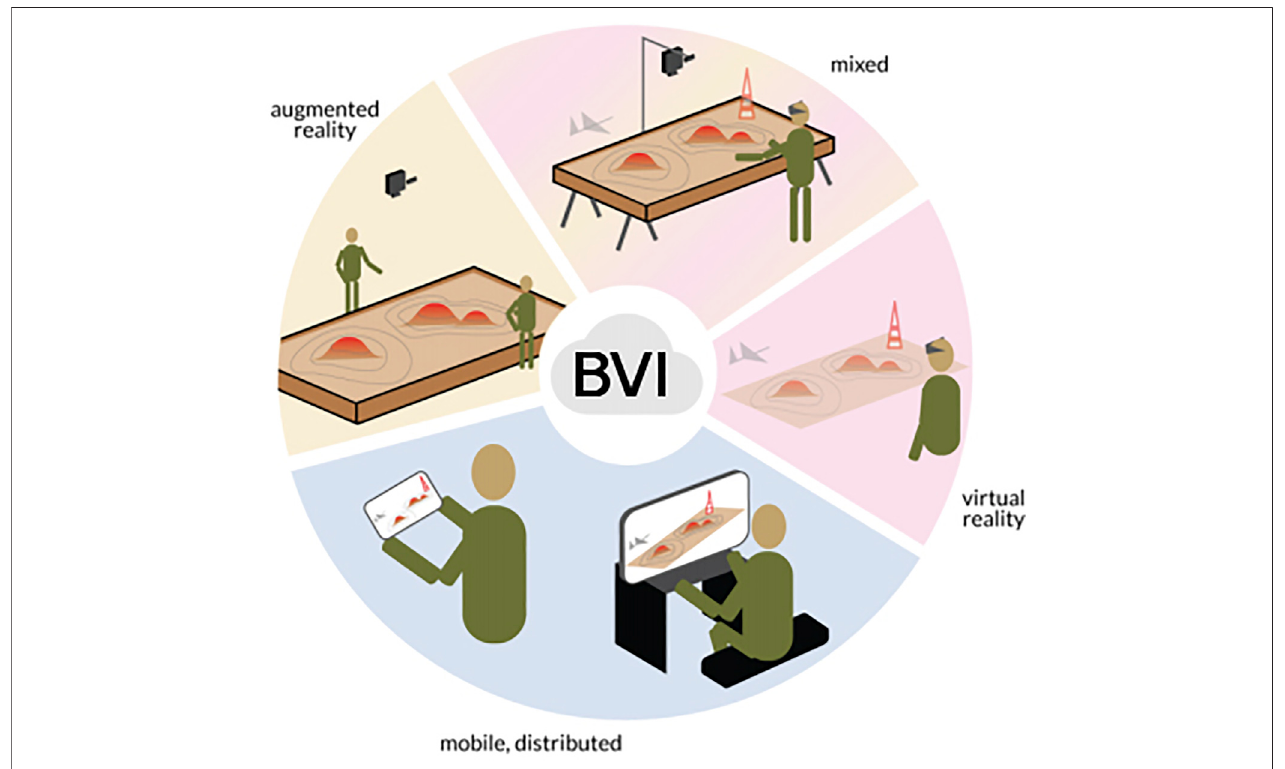
FIGURE 1 | Sample applications of